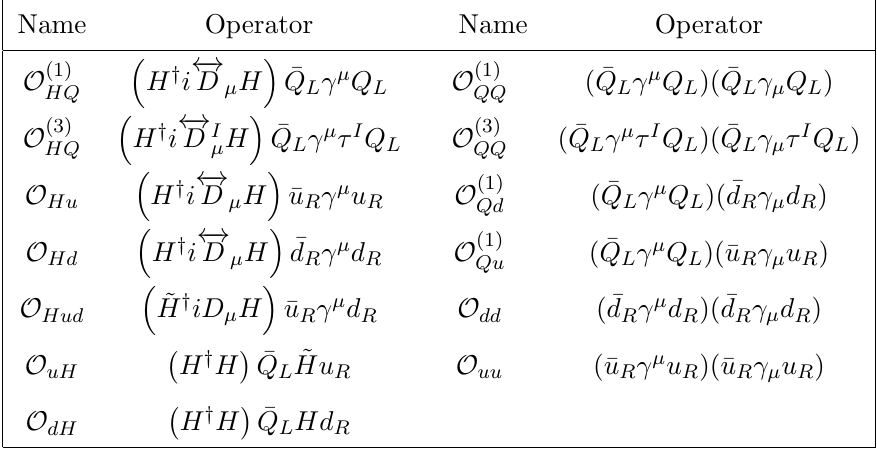
SU(2) L U(1) Y -invariant operators that receive contributions (cid:2) (cid:2)